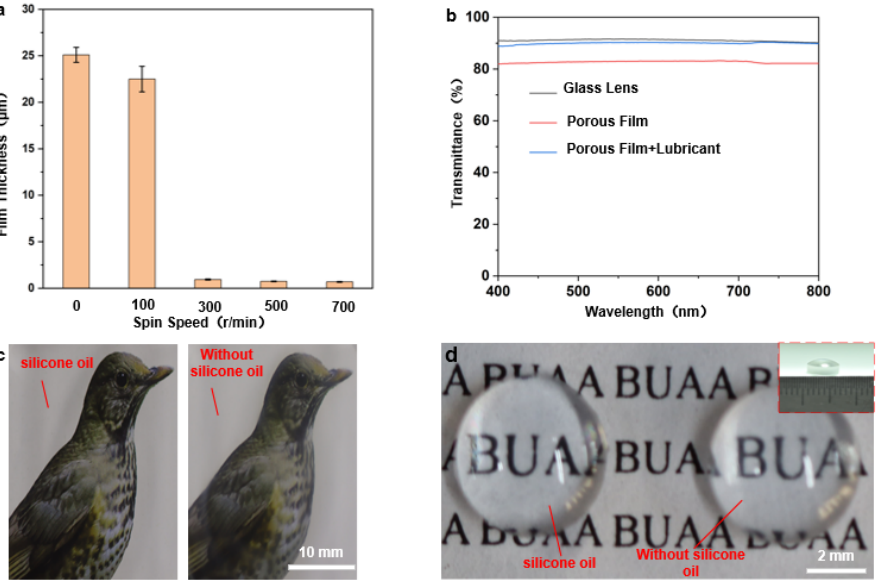
Figure 4. ( a ) Graph of spin-coating speed in relation to film thickness (the picture above the graph shows the comparison between the light transmission rates of the corresponding films); ( b – d ) Optical transparency analysis of porous films: ( b ) transmission rates of dry and wet porous films at different visible spectra; ( c ) optical photographs of porous films on flat glass before and after the addition of silicone oil (the right side is without silicone oil); ( d ) optical photographs of porous films on curved convex mirrors (diameter 6 mm ) before and after the addition of lubricating oil (without silicone oil on the right).